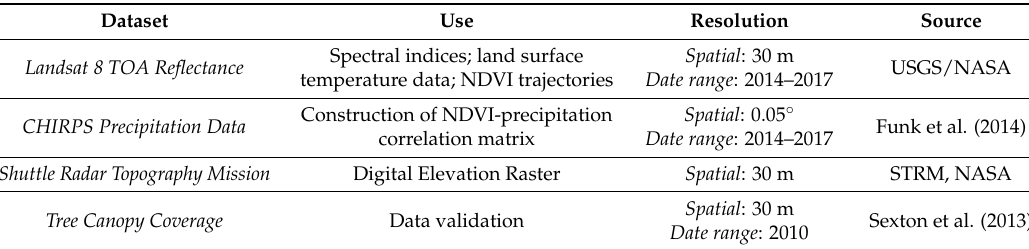
Figure 1. Overview of the classification approach. Red shading indicates primary datasets used in this analysis. * NS refers to non-seasonal data (brightness, wetness, greenness, and temperature); S refers to multi-seasonal data (rainy/dry hot/dry cool brightness, wetness, greenness, and temperature); T refers to elevation, slope, and aspect data; and P refers to the correlation matrix between precipitation and normalized difference vegetation index (NDVI). Treatments are described in greater detail in Section 2.8. Table 1. Datasets Used in Land-Cover